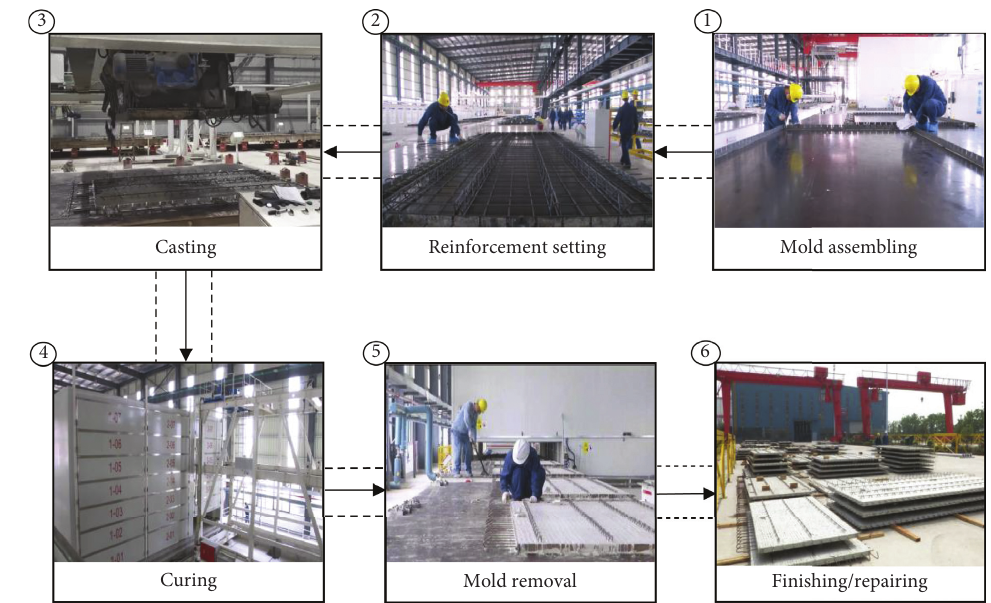
Figure 1: Production flowchart of PC components.